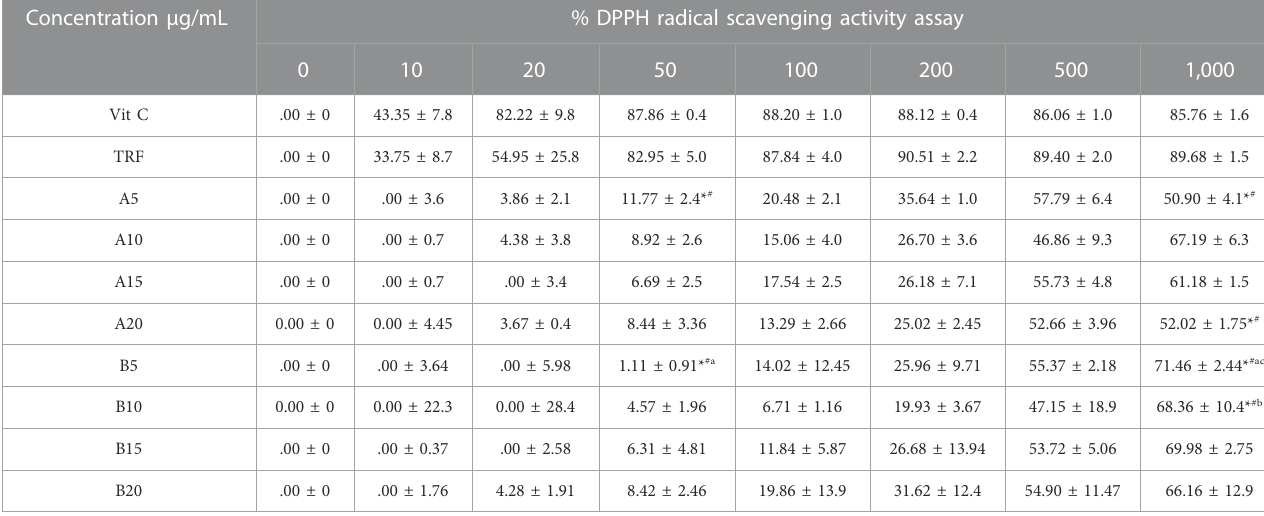
TABLE 3 DPPH radical scavenging activity in both soil and soilless ginger. Data presented as mean ± SD (n = 3). Concentration µg/mL